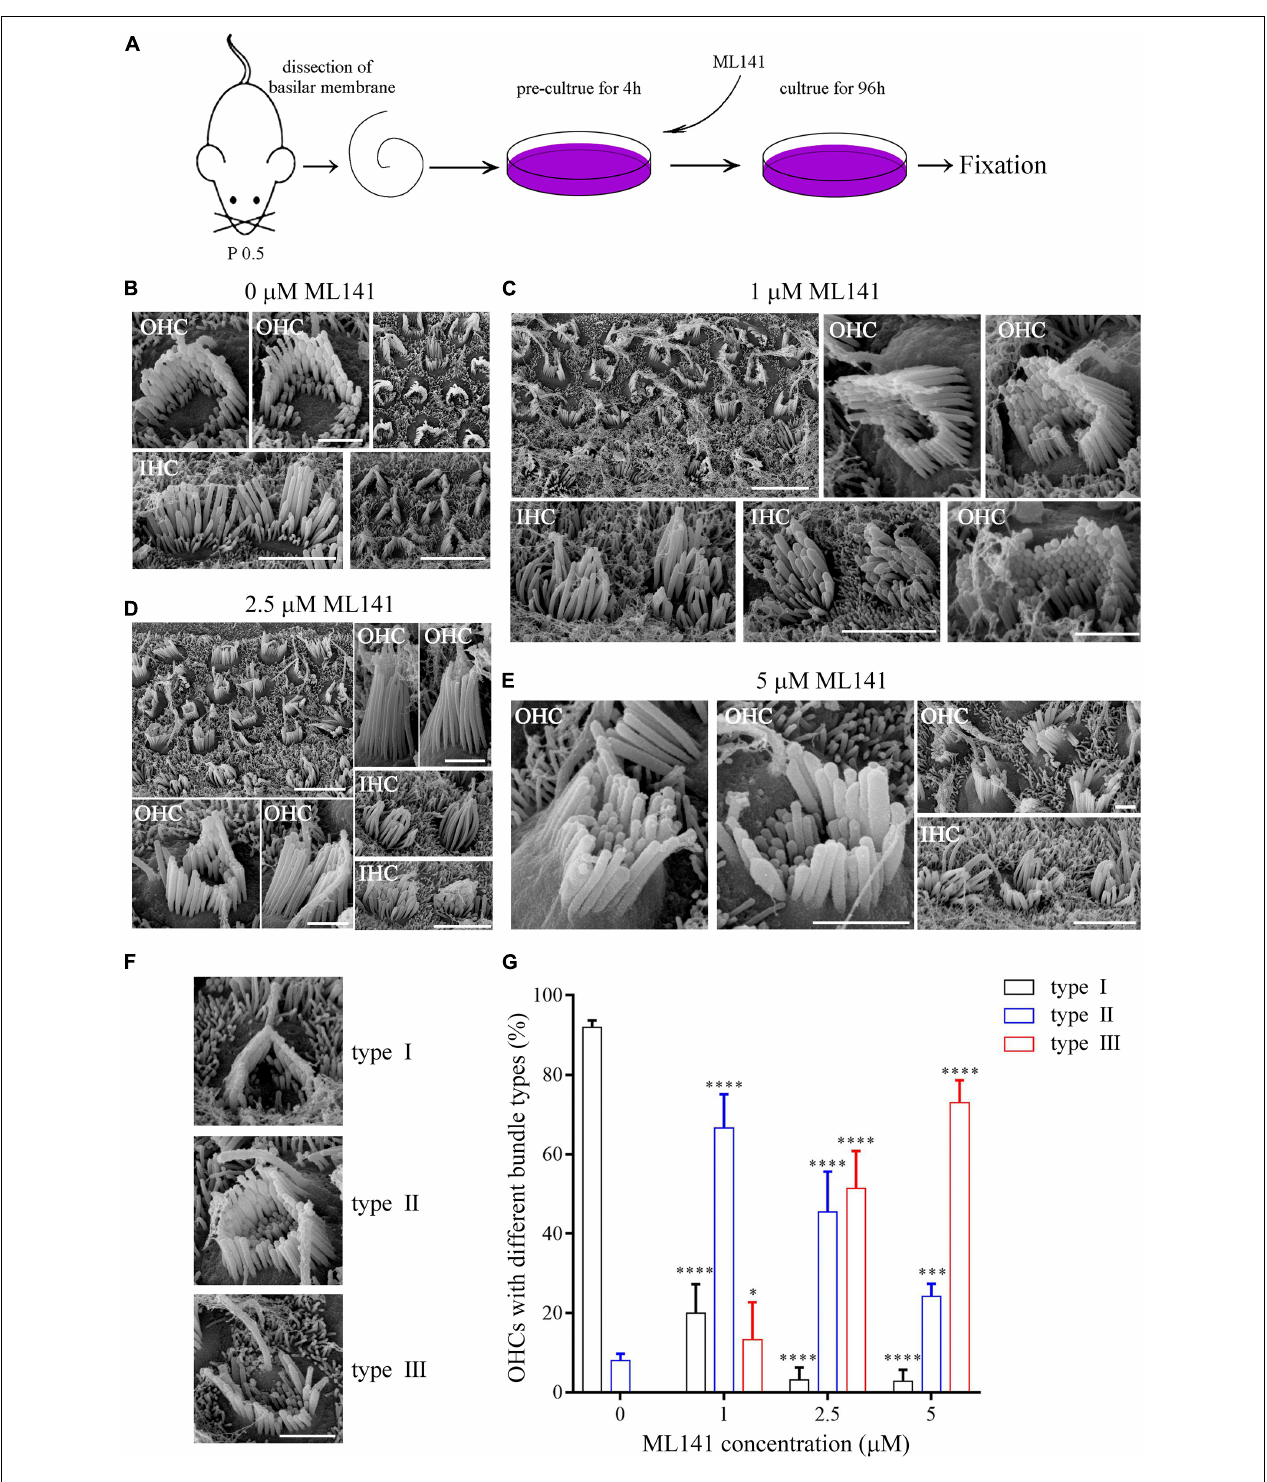
FIGURE 3 | CDC42 inhibitor ML141 treatment leads to stereocilia development deficits. (A) Schematic drawing of the strategy of ML141 treatment and SEM imaging. (B–E) SEM images of hair bundles after treatment of ML141 at different concentrations as indicated. Scale bars: 5 µ m in low magnification images; 1 µ m in high magnification OHC images; 3 µ m in high magnification IHC images. (F) Representative images showing three types of hair bundles with different PCP phenotypes. Scale bar: 1 µ m. (G) Percentages of hair cells of different types were analyzed from three independent experiments. The bars indicate the mean ± SEM values. ∗ P < 0.05; ∗∗∗ P < 0.001; ∗∗∗∗ P < 0.0001.